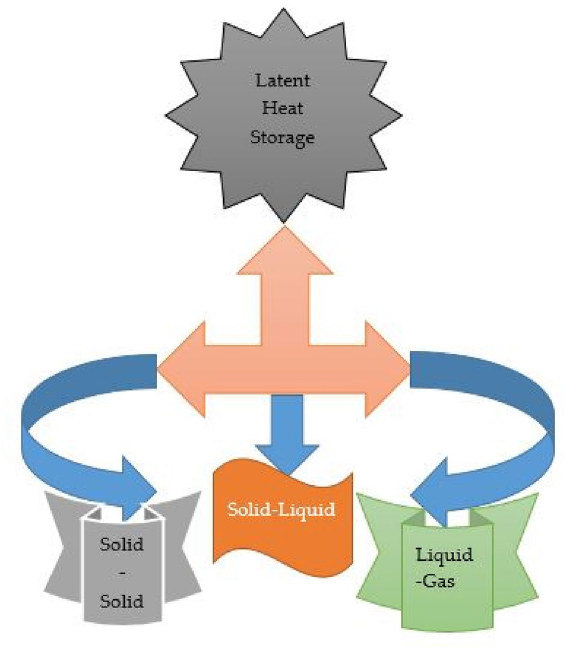
Figure 3. Latent heat storage.